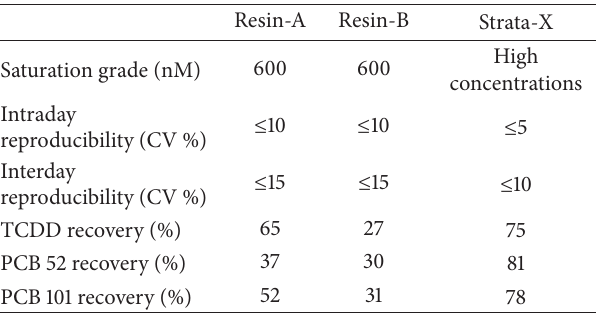
Table 3: SPE cartridges recovery test for TCDD, PCB 52, and PCB 101. Saturation grade, intra- and interday reproducibility, were reported. Resin A: EWFQPW-Nova Syn TGA, Resin B: W-Nova Syn